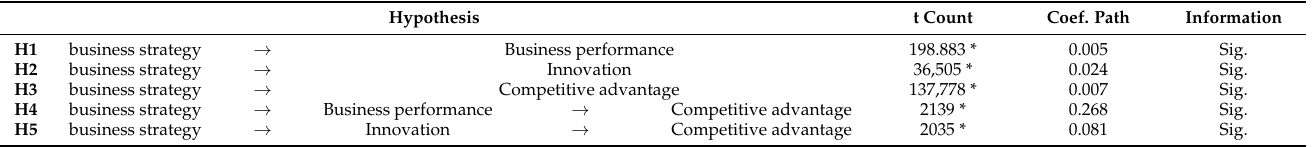
Table 5. Testing the research